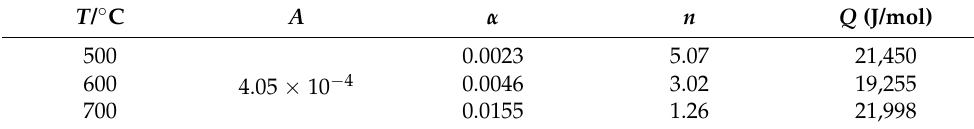
Table 2. Table 2. Parameters of the Arrhenius constitutive model. Table 2. Parameters of the Arrhenius constitutive model.